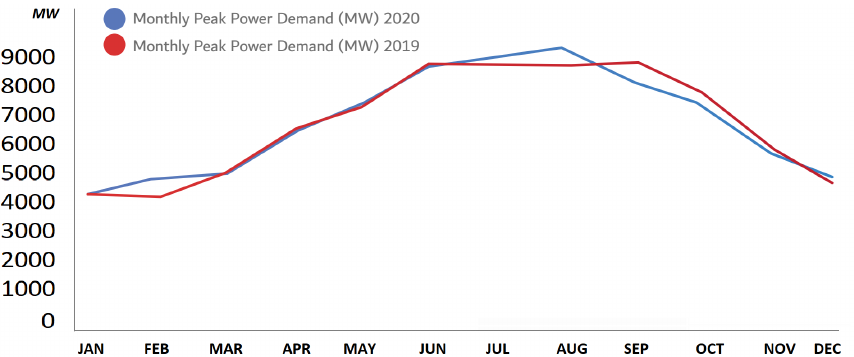
Figure 3. Monthly peak electric power demand for Dubai in 2020 compared to 2019